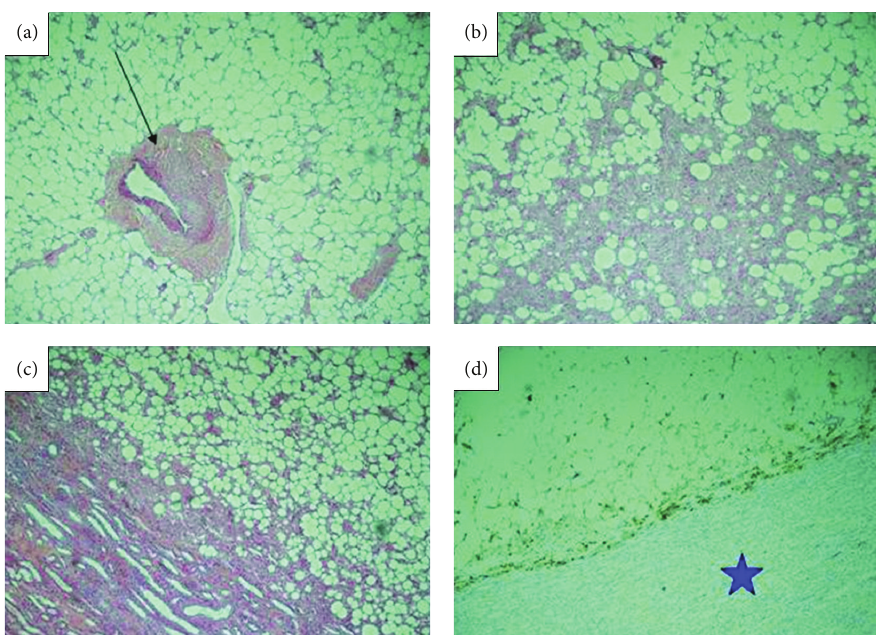
Figure 4: Extrarenal mass (haematoxylin and eosin). Photomicrograph of the mass demonstrate mature adipose tissue with a tortuous thick blood vessel (black arrow) ((a); × 20) and bundles of smooth muscles lacking elastic tissue lamina ((b); × 40), adipose tissue with small areas of smooth muscle with epithelioid features ((c); × 40). Focal staining with HMB45 antibody was positive (blue star) ((d); × 40), consistent with angiomyolipoma. Reproduced from